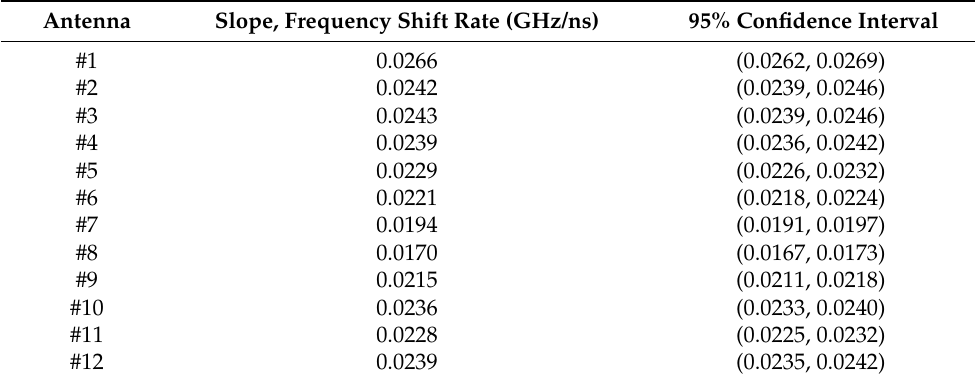
Figure 5. The centroid frequency of the radar echo versus time. ( A – L ) are the centroid frequencies of radar echoes obtained by antennas #1 to #12 as transmitting antennas and other antennas as receiving antennas, respectively. The horizontal axis is the two-way traveling time (ns) and the vertical axis is the centroid frequency (GHz). The pink line is the best fitting result. It is worth noting that we use the data prior to band-pass filtering to calculate the frequency shift rate. Table 2. Parameters of the best fitting lines and their 95% confidence